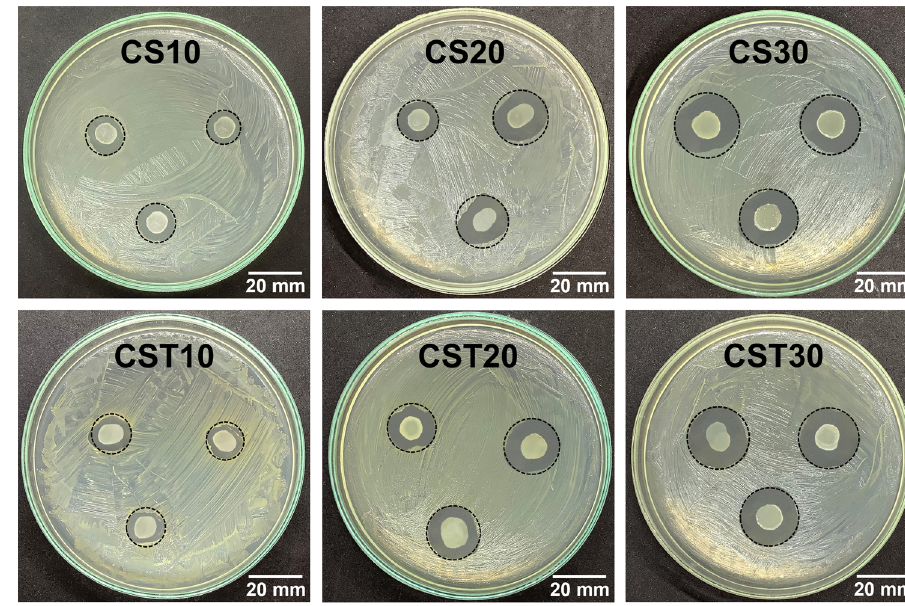
Figure 8: Photographs of inhibition zone against S. aureus of the nano fi ber mats with and without T80